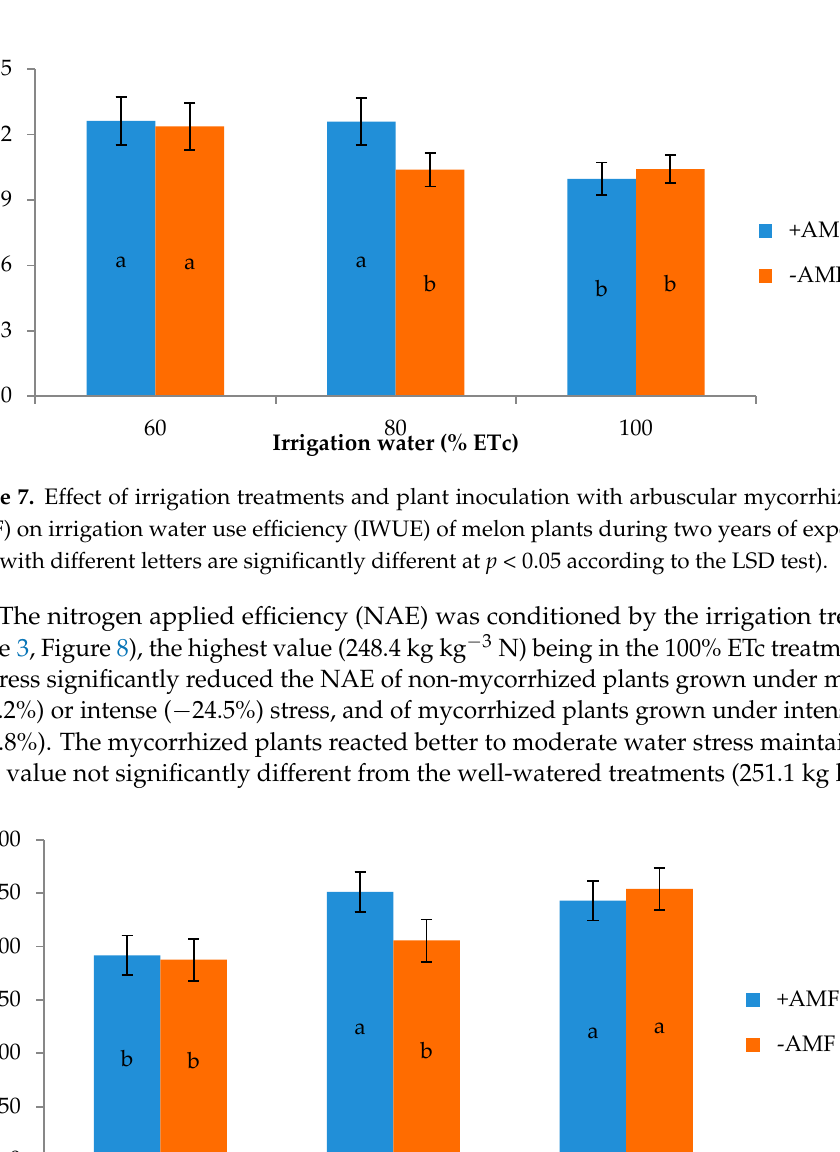
Figure 9. Relationship between relative yield (yield/maximum yield) and irrigation water of inocu- lated (+AMF) and uninoculated ( − AMF) melon plants during two years of experiments. ** signifi- cant at p < 0.01; *** significant at p < 0.001. 3.3. Fruit Characteristics Unstressed plants produced the greatest and heaviest fruits (2405.0 g and 2479.4 mL on average), while the highest water stress (60% ETc) reduced significantly fruit weight and volume only in the uninoculated plants by 19.2 and 18.4%, respectively (Figure 10).